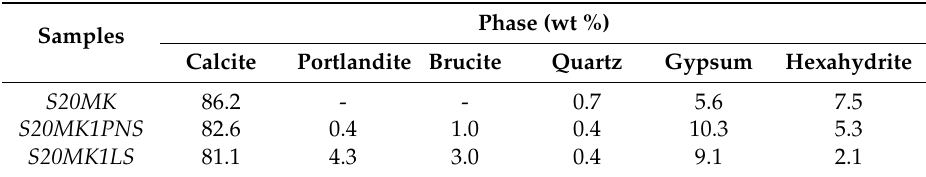
Table 7. Results of the Rietveld quantitative phase analysis of the XRD after three sulphate attack cycles, showing the percentages of the different phases.